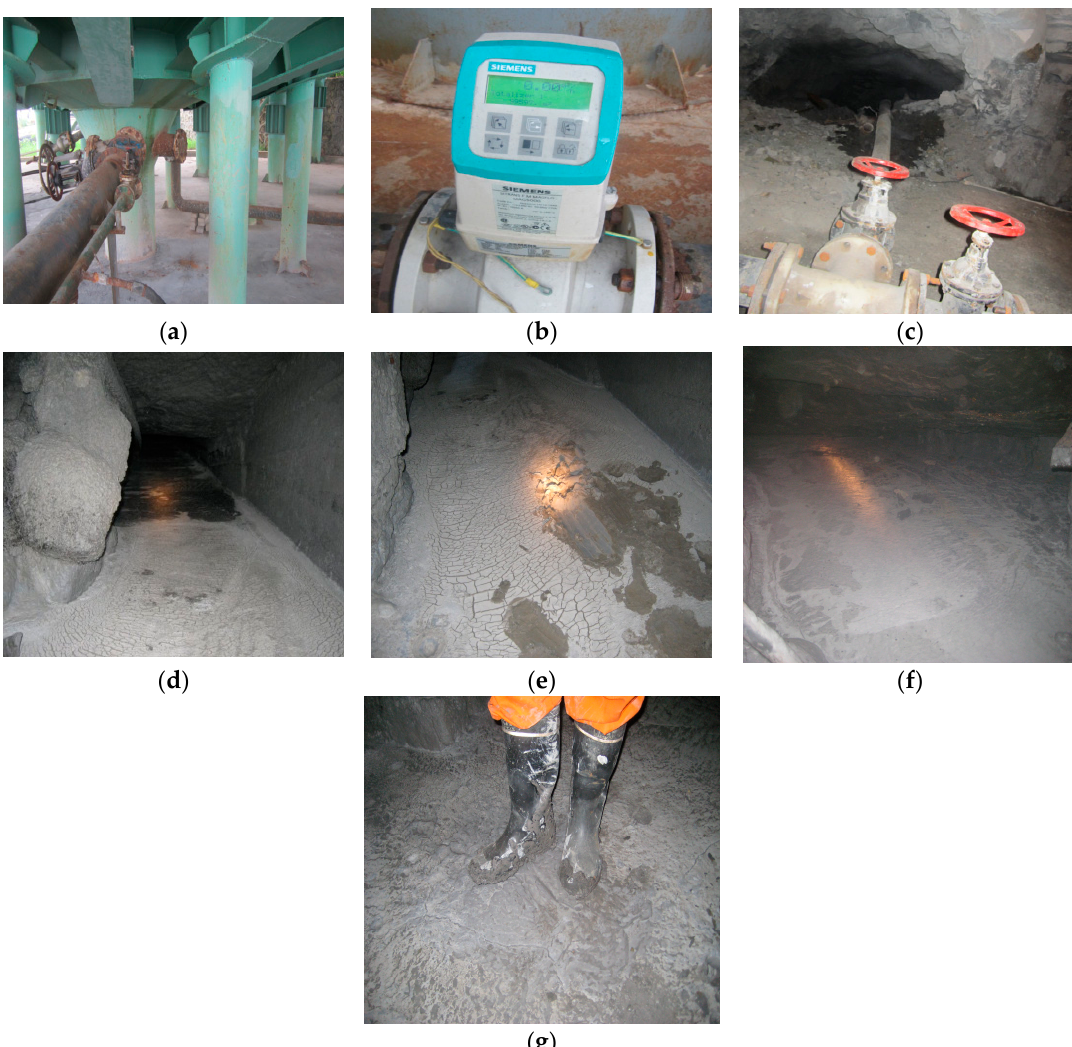
Figure 15. Backfilling transportation industrial test. ( a )Thickener; ( b ) Electromagnetic flowmeter; ( c ) Pipeline transportation; ( d ) 24 h after filled(concentration 55%); ( e ) 72 h after filled(concentration 55%); ( f ) 24 h after filled (concentration 60%); ( g ) 72 h after filled (concentration 60%).